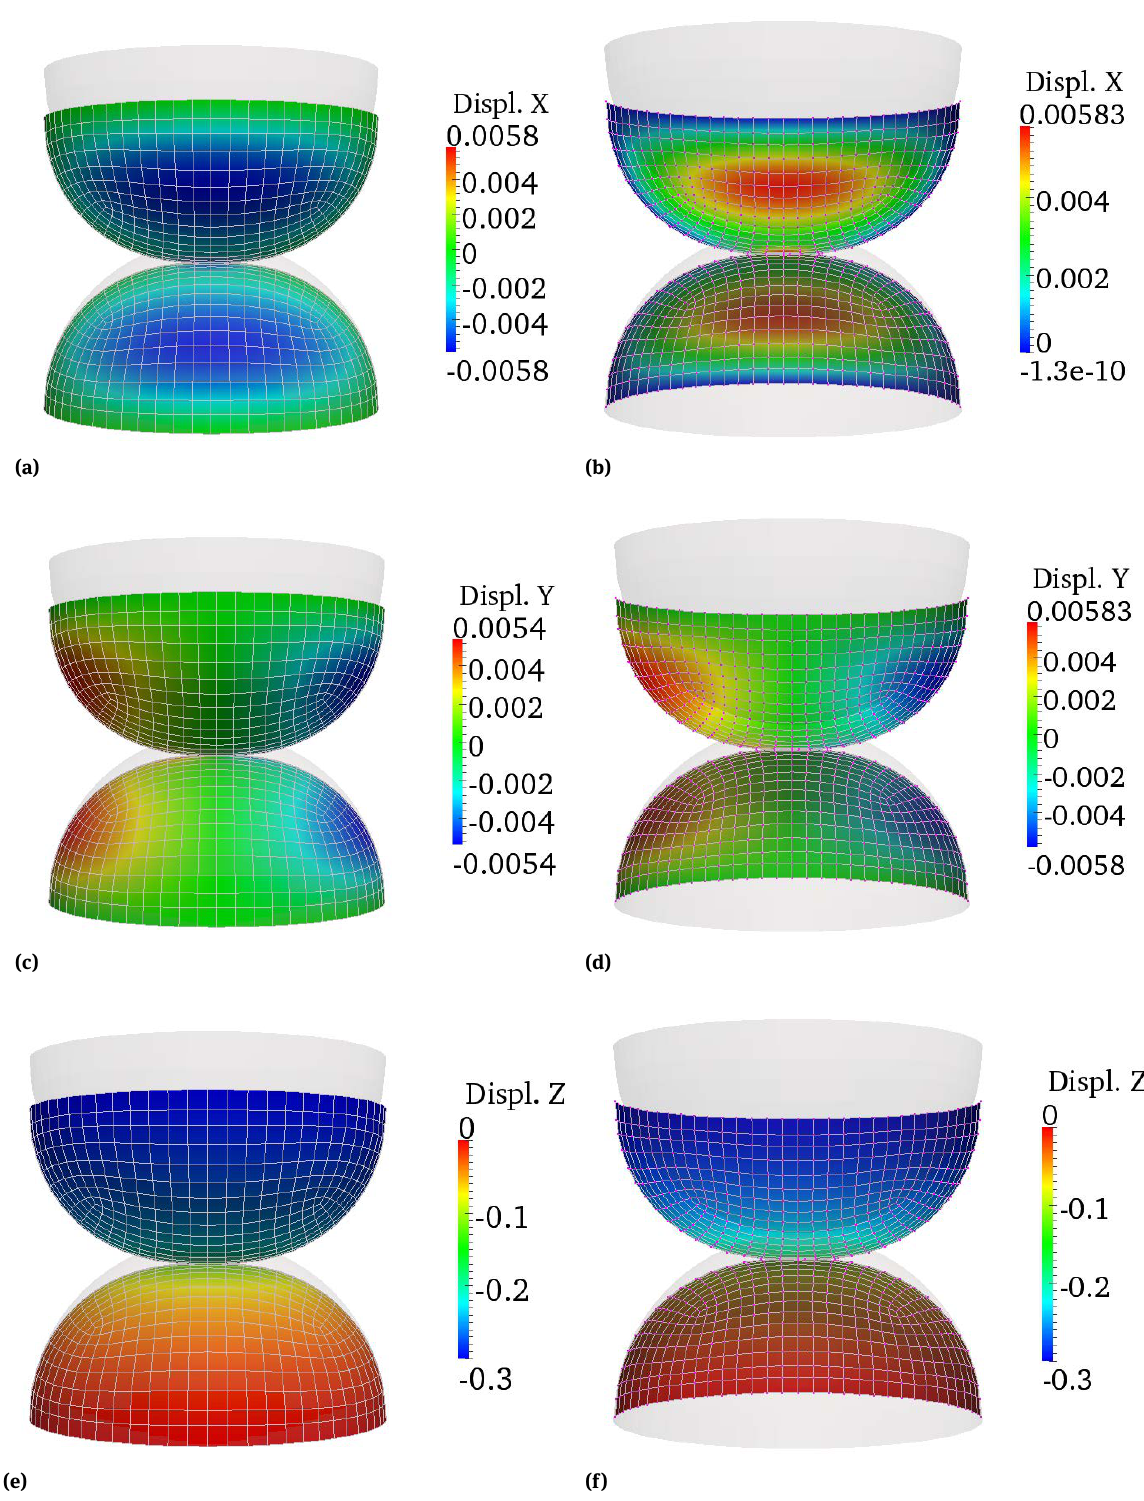
Figure 17: Hemispheres in normal contact: undeformed and deformed shape and displacement contours for step